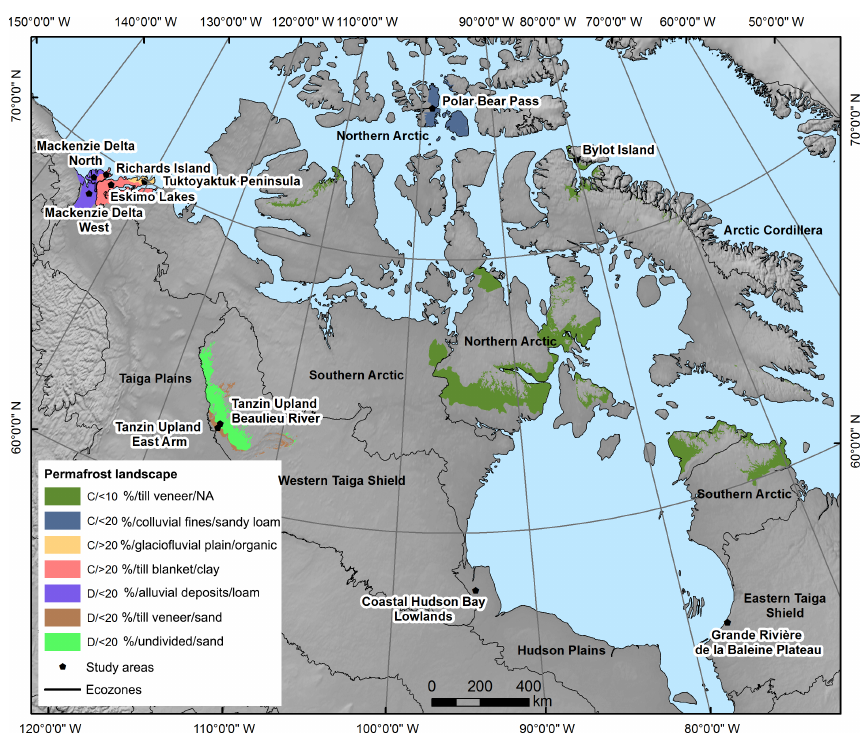
Figure D2. Study areas and associated permafrost landscapes in Canada. Legend lists type of permafrost extent (C: continuous; D: discon- tinuous; S: sporadic), ground ice content (vol%), surficial geology, and lithology. Shadowed labels name study areas with waterbody maps. Black lines and labels denote ecozones.